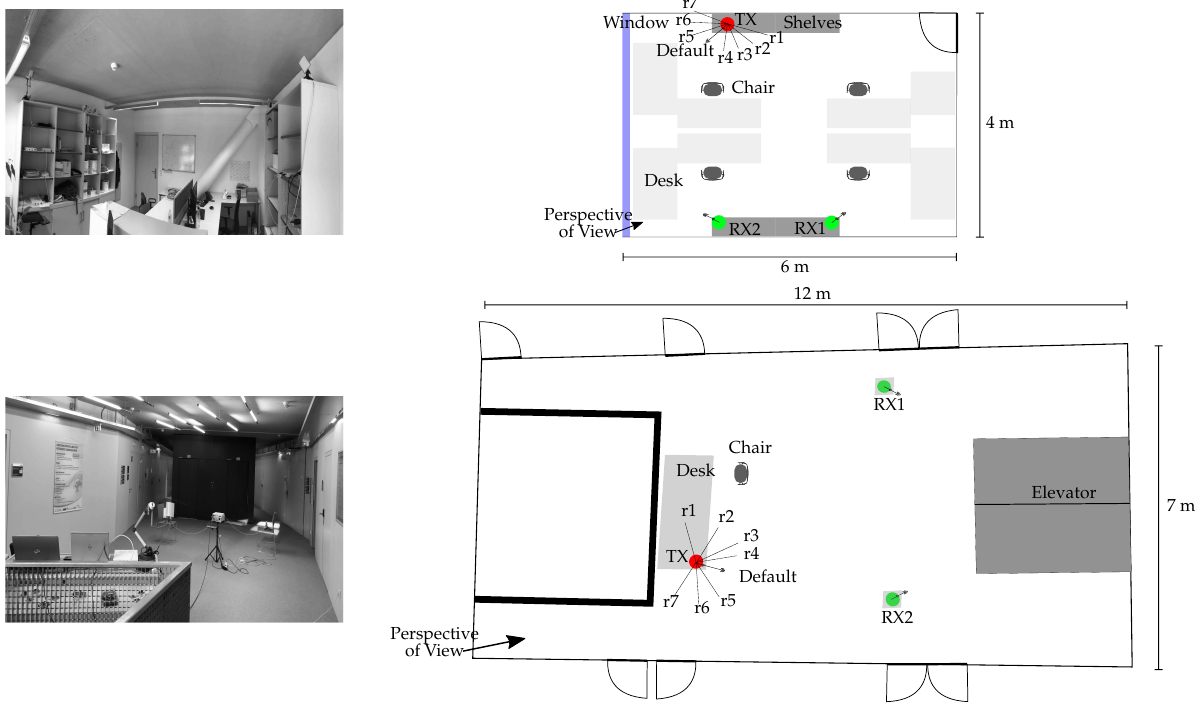
Figure 8. Measurement environments: (top) office (4m × 6m) and (bottom) hall (7m × 12m), depicted with photos and the layout. The transmitter (indicated by TX) and two receivers (indicated by RX1 and RX2) are denoted. Orientations r1, r2, . . . , r7 are considered as physical tamper